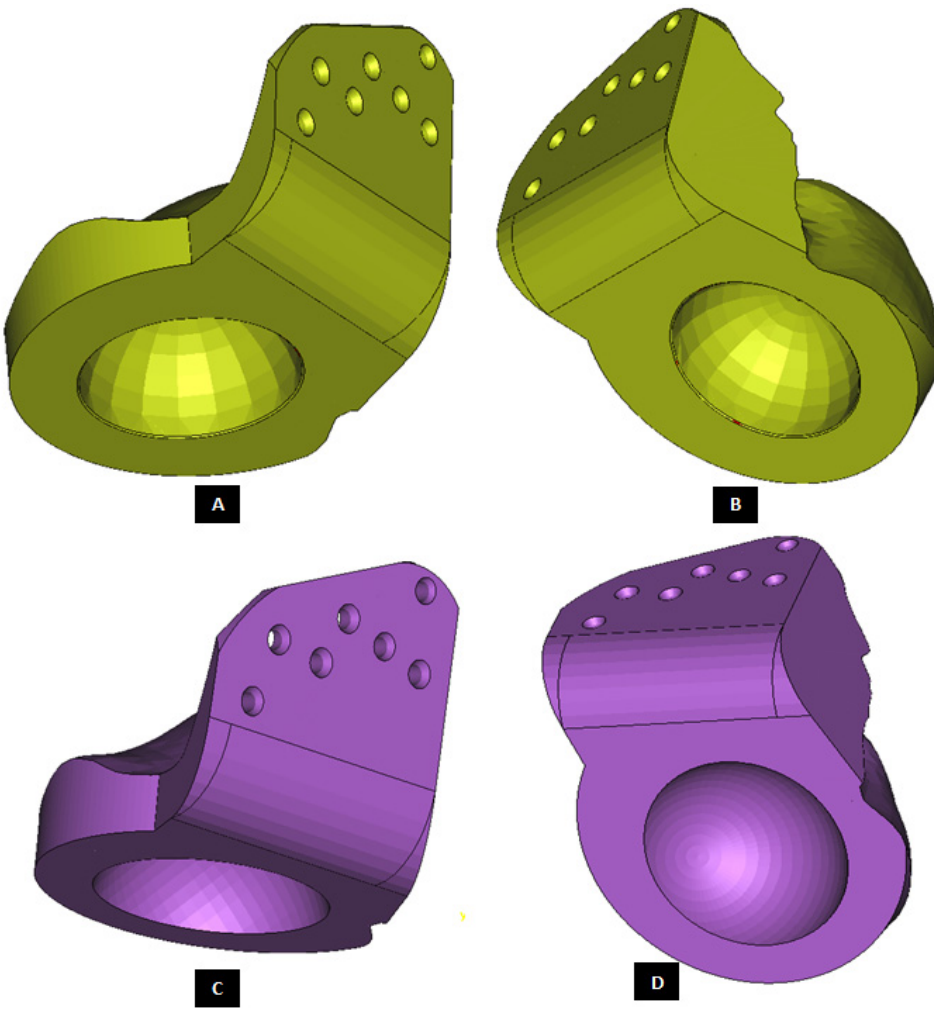
Figure 18. Custom-designed fossa prosthesis with circular articular surface. The device shown in ( A , B ) has relatively smaller articulating circular hole compared to the one shown in ( C , D ). Addi- tionally, articulating surface of the device shown in ( C , D ) is slanted anteriorly to augment anterior translation of condylar head during mastication.